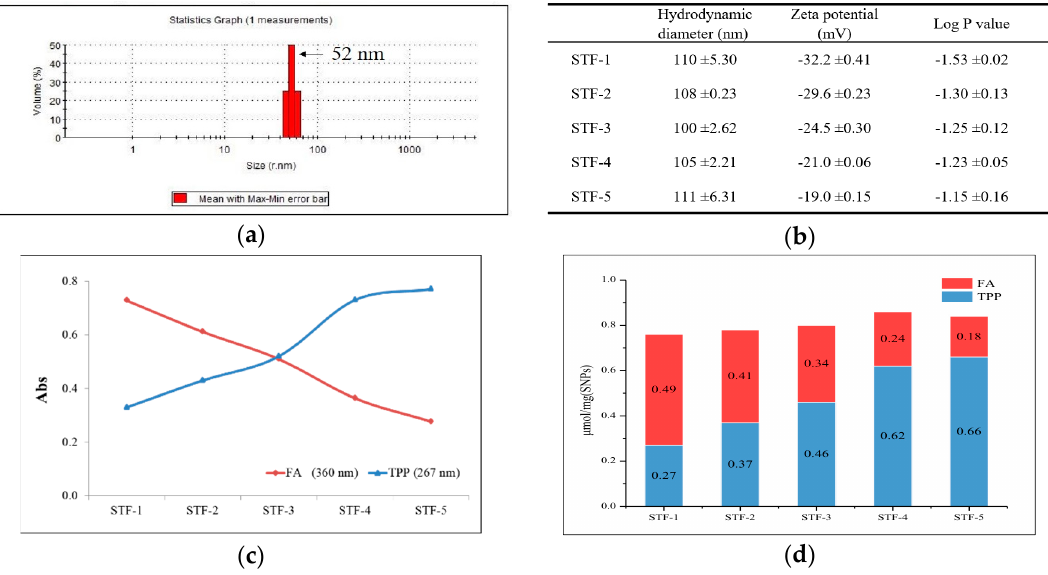
Figure 3. Dynamic light scattering (DLS) analysis and spectroscopic analysis of nanoparticles. ( a ) Hydrodynamic diameter of SNPs in distilled water. ( b ) Dynamic light scattering studies and Log P value of STF-1 to 5. ( c ) UV absorbance of 0.1 mg / mL STFs in distilled water. ( d ) The amount of FA and TPP on SNP surfaces ( µ mol /